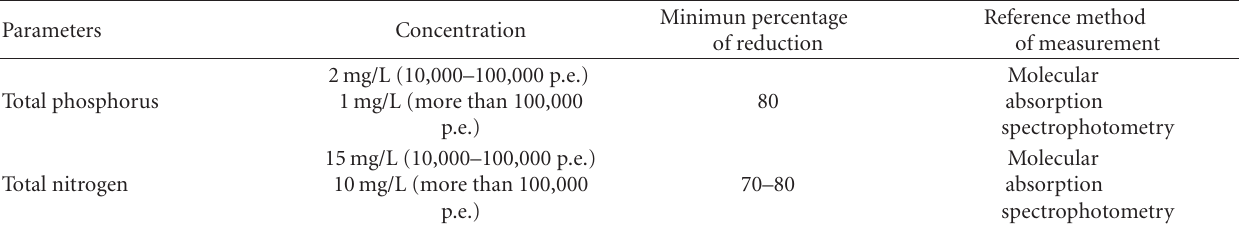
Table 1: Requirements for discharges from urban waste water treatment plants to sensitive areas which are subject to eutrophication. Council directive of 21 May 1991 concerning urban waste water treatment